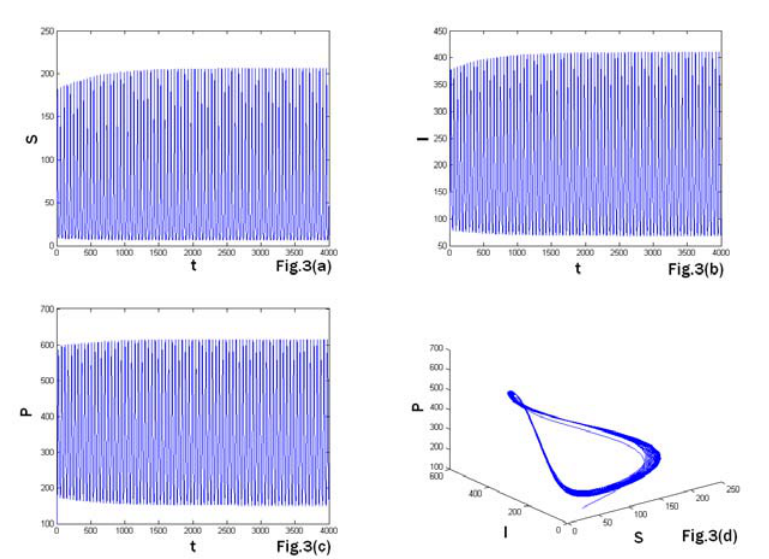
Figure 3. Time evolution of all the population for the model (1.2) with τ = 1 and initial value (50,80,100). (a), (b) and (c) are S , I and P versus t , respectively. And (d) is the projected S − I − P phase